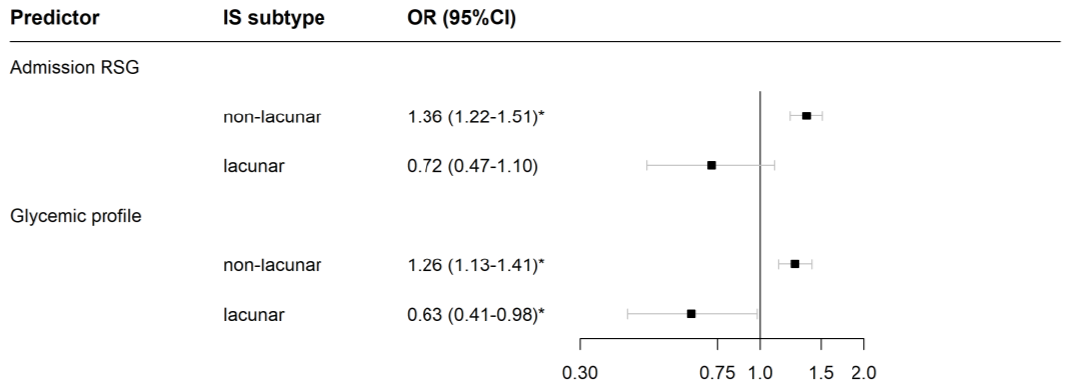
Figure 2. Association of continuous glucose predictors with poor outcome of ischemic stroke (IS) in patients without persistent or delayed hyperglycemia. Odds ratios (OR) are for a unit increase in random serum glucose (RSG) on admission and early glucose profile (defined as the difference of fasting serum glucose measured the morning after admission and RSG). The logistic model was adjusted for age, sex, prestroke disability, admission National Institutes of Health Stroke Scale score, and reperfusion therapy. Patients were stratified by IS subtype because the model included significant interactions of admission RSG and early glycemic profile with this characteristic. Poor outcome was defined as early neurological deterioration, severe stroke at Stroke Unit discharge, or death at 30 days after stroke onset. Analysis included only patients with FSG < 7.8 mmol/L. Data are for 2781 non-lacunar patients (501 cases) and 758 lacunar patients (31 cases). Significant ORs ( p -value < 0.05) are marked with *.